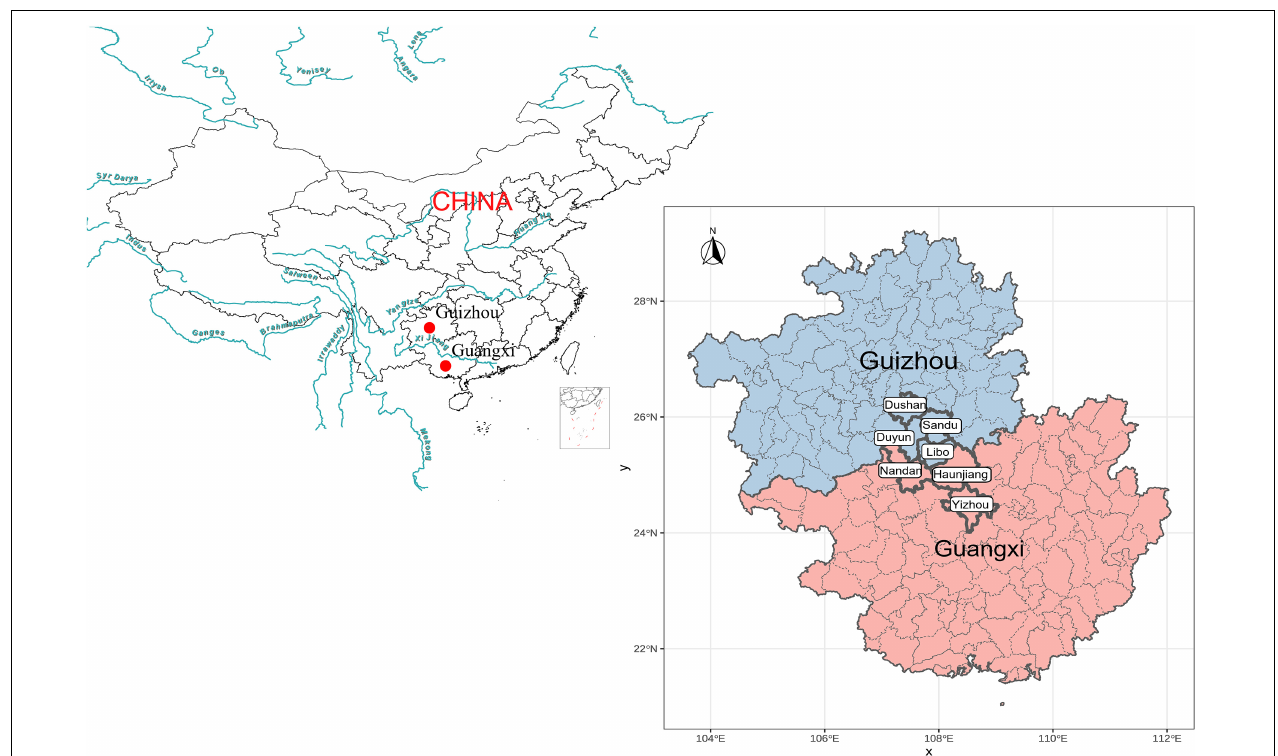
FIGURE 1 | Geographical positions of new collected Sui people from Guangxi and Guizhou Province, Southwest